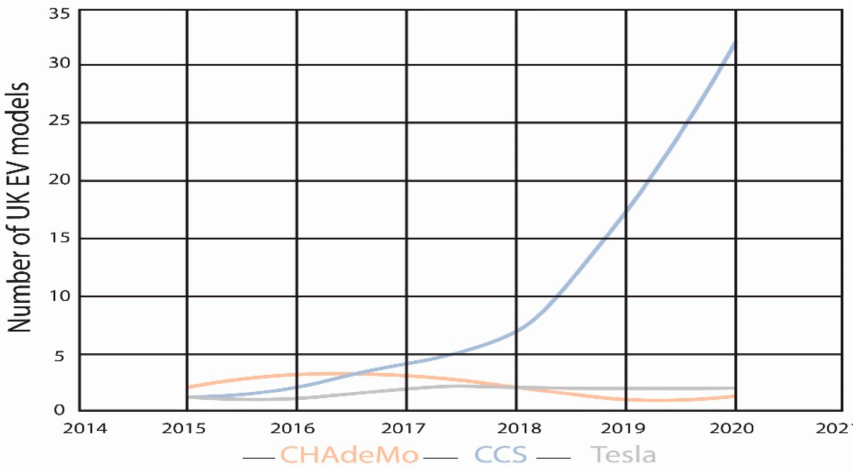
Figure 10. CCS adoption in UK, versus CHAdeMO and Tesla